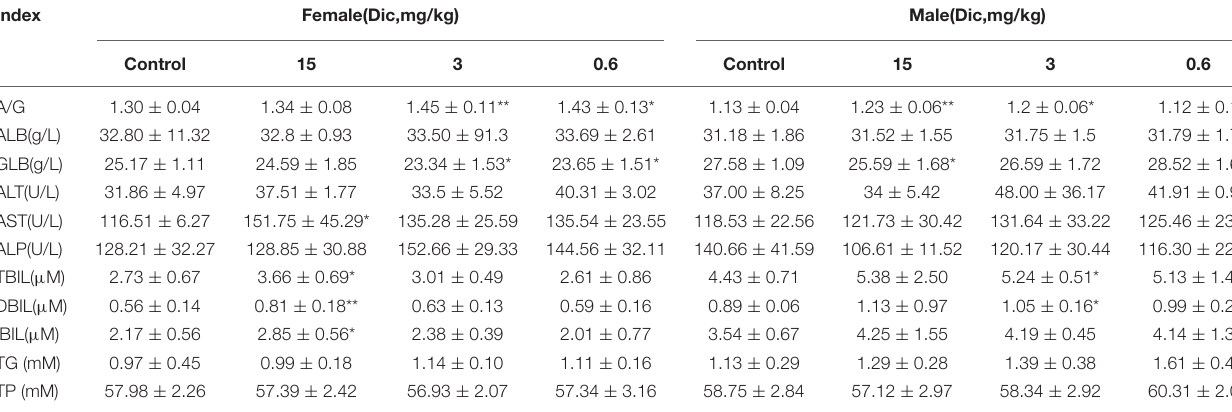
TABLE 1 | Effects of oral administration of dictamnine on the biochemical parameters in